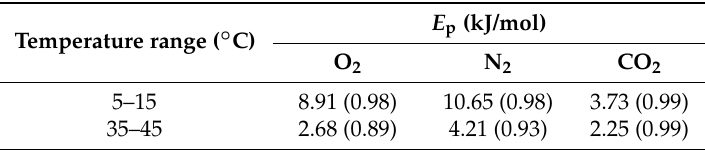
Table 2. Activation energy of the gas transmission rate process for O 2 , N 2 and CO 2 . In brackets: R 2